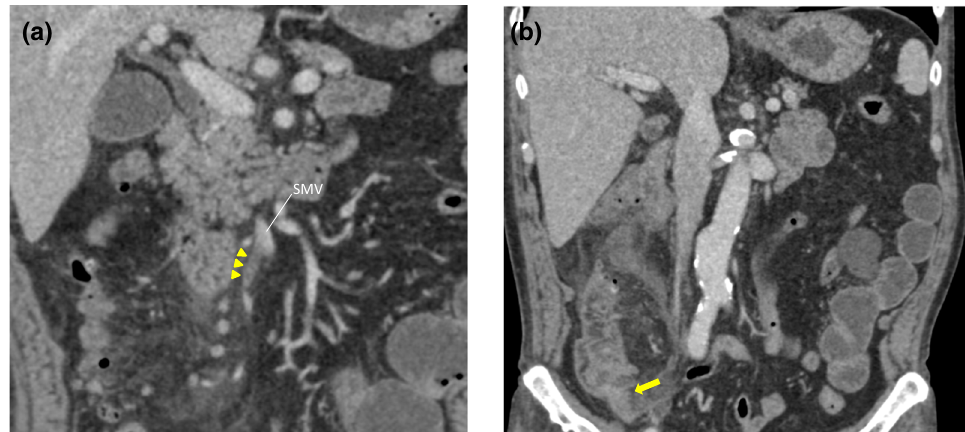
Fig. 1 a Abdominal contrast-enhanced CT on admission. Thrombus is found from the ileocolic vein to the superior mesenteric vein. Arrowheads: mesenteric vein thrombus. b Abdominal contrast-enhanced CT on admission. Periappendiceal fat standings and unevenness of the appendix wall are found. Appendiceal diverticulitis is suspected. Arrow: unevenness of the appendix wall